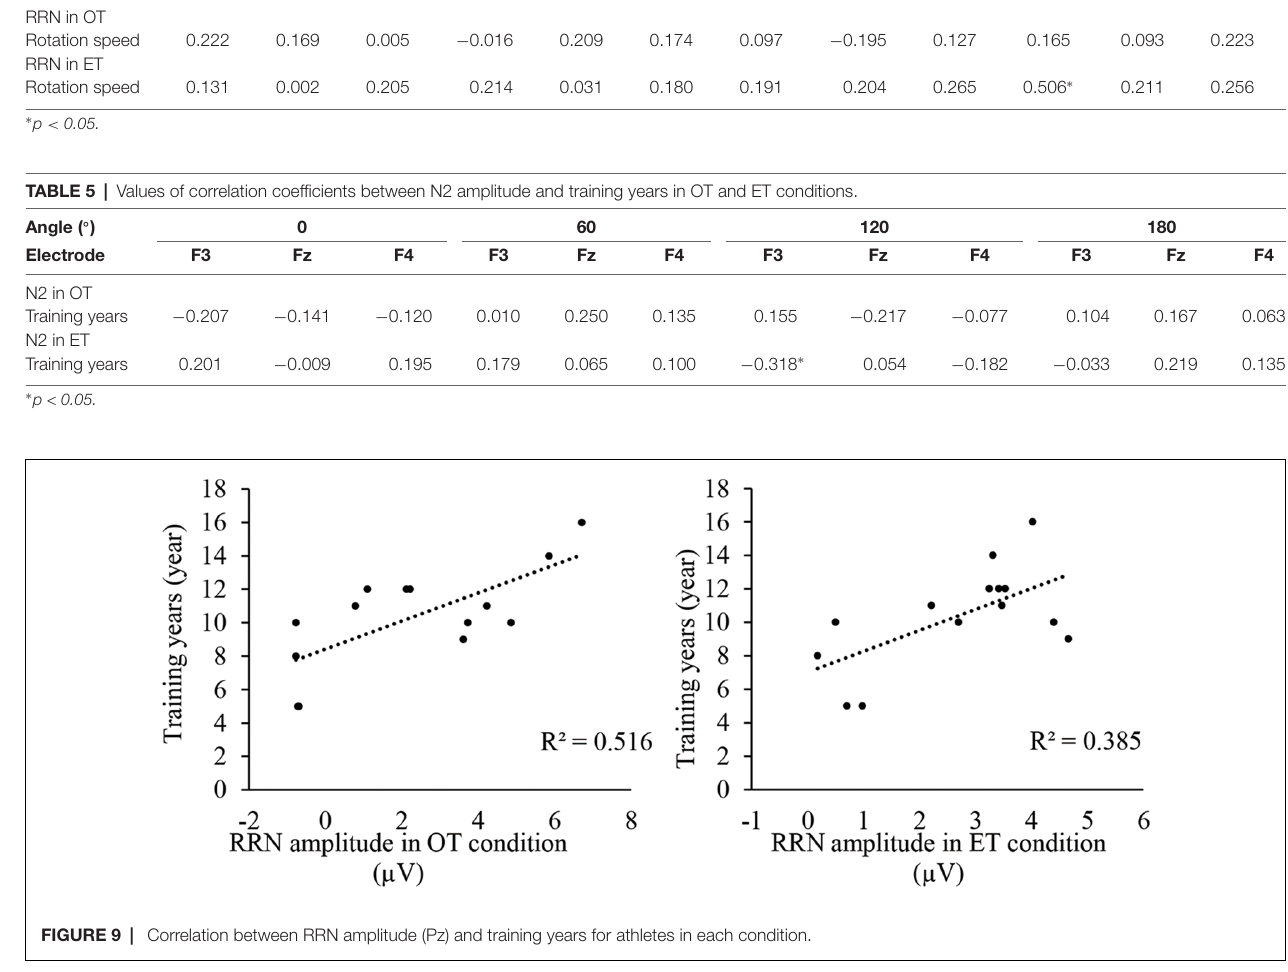
TABLE 4 | Values of correlation coefficients between RRN amplitude and rotation speed in OT and ET conditions. Angle ( ◦ ) 0 Electrode